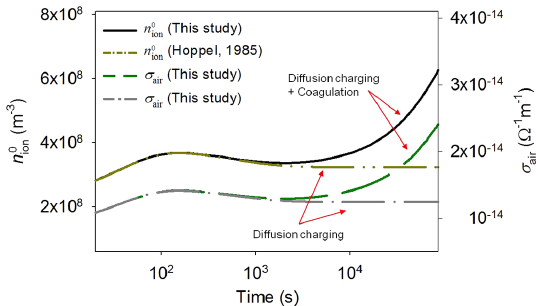
Figure 11. Time evolution of the mean ion concentration, n 0 and air conductivity, σ air in the postulated atmosphere of Hoppel (1985) ( d p = 0 . 06µm, N t = 2 . 3 × 10 10 m − 3 ; q = 10 7 m − 3 s − 1 )